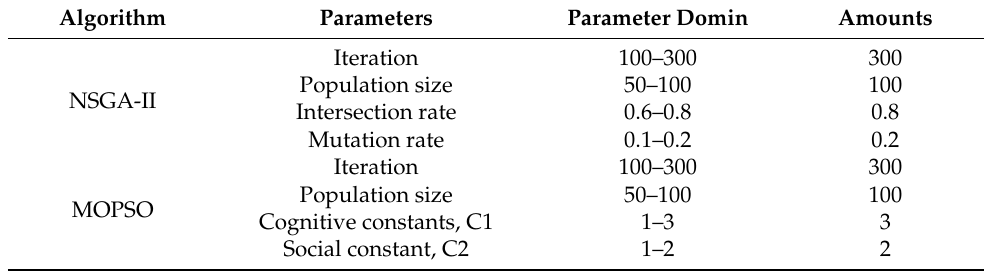
Table 16. Optimal values of parameters in algorithms.